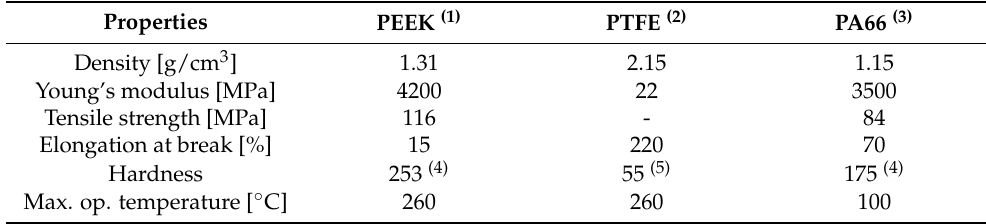
Table 3. Polymer